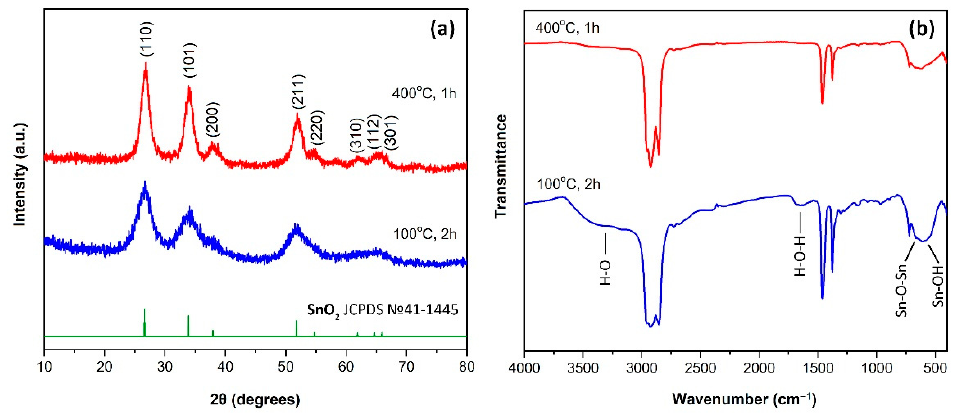
Figure 3. XRD patterns ( a ) and infrared spectra ( b ) of the semiproduct and SnO 2 nanopowder obtained by additional heat treatment.